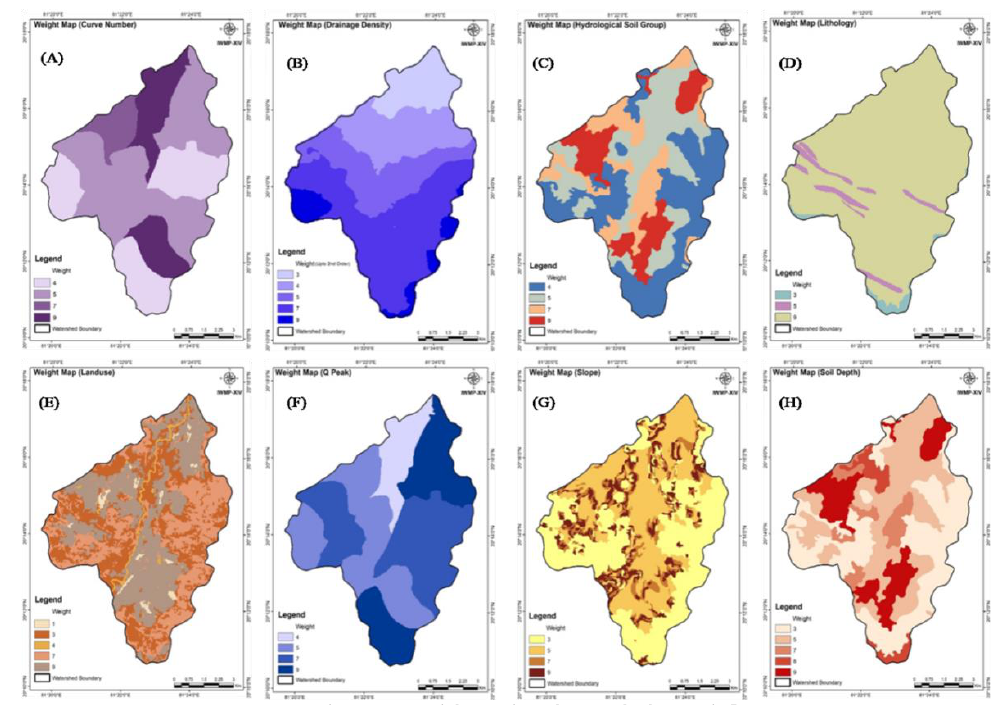
Figure 4: Weight assigned to each thematic layers